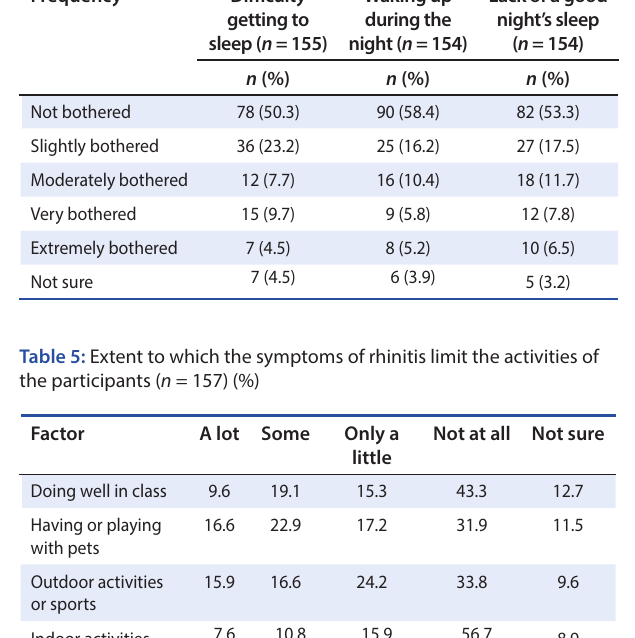
Table 4: Effect of symptoms of rhinitis on sleep Frequency Difficulty getting to